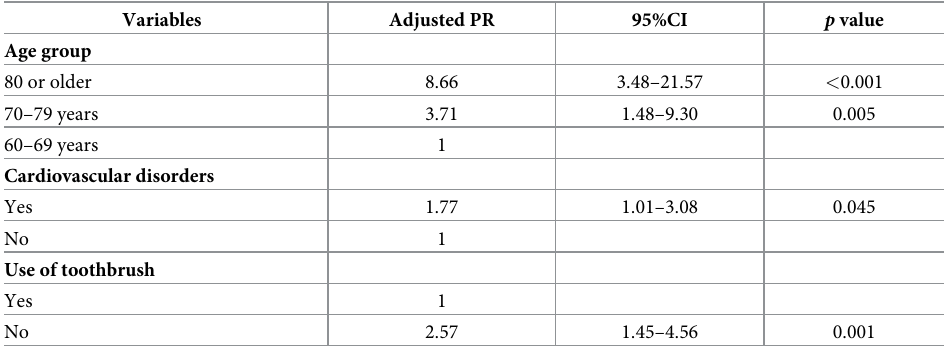
Table 4. Older people’s variables that remained associated with dependence in instrumental activities of daily liv- ing (IADL) in the Poisson regression